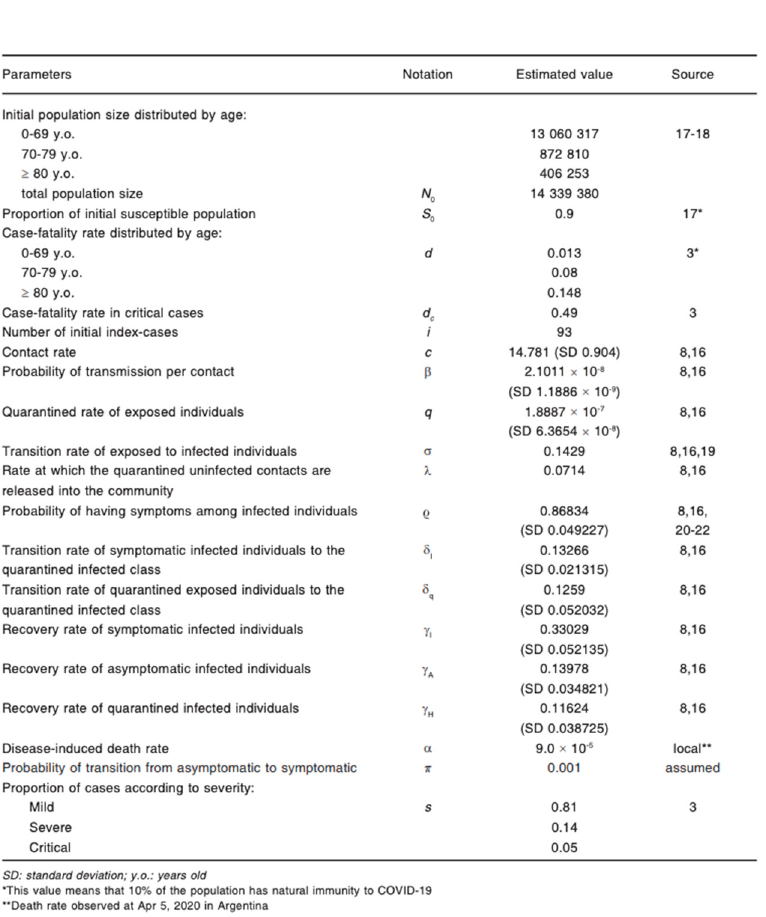
Figure 6. COVID-19 transmission forecasting using the SEIR compartmental model for Buenos Aires [33]. Aires